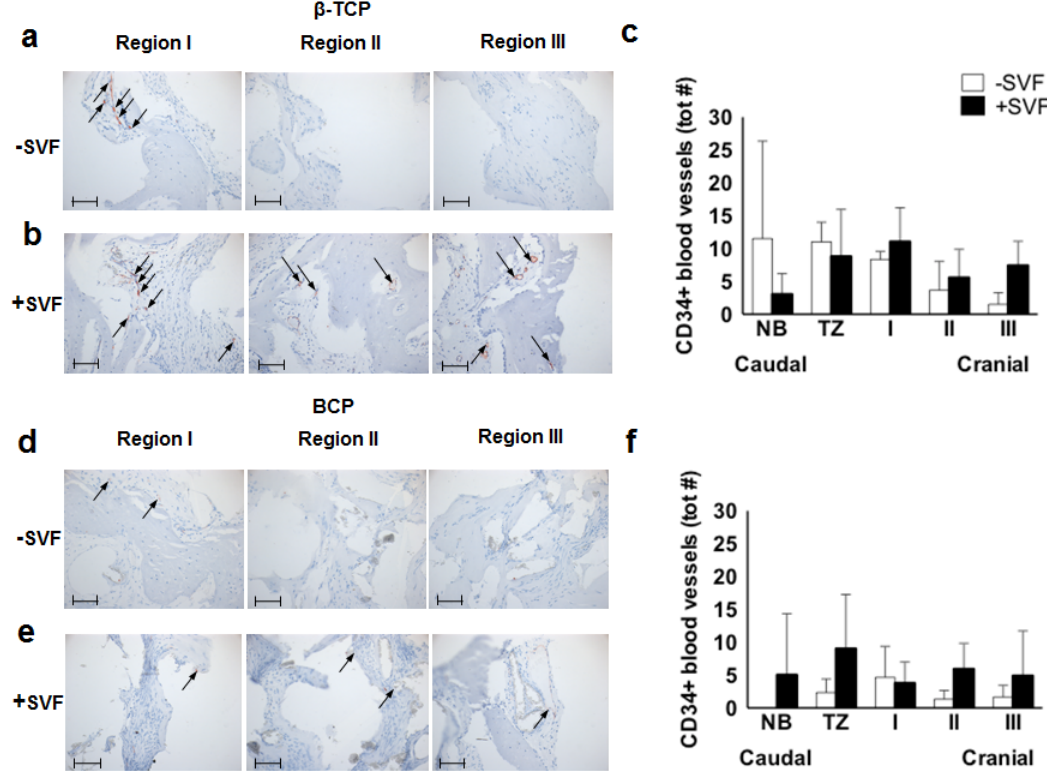
Figure 3. Immunohistochemical analysis of CD34, a marker of endothelial cells as well as stem cells such as endothelial progenitor stem cells and hematopoietic stem cells, of a maxillary bone biopsy from a patient treated with β -TCP ( a – c ) and BCP ( d – f ). Magnification: 200 × . The scale bar represents 100 µ m. The total number of CD34+ blood vessels of selected bone biopsies taken from control sides without stem cells (white bars; n = 3), and study sides with stem cells (black bars; n = 4) from patients treated with β -TCP ( b ) or BCP ( e ). β -TCP, β -tricalcium phosphate; BCP, biphasic calcium phosphate; NB, native bone; TZ, transition zone; SVF, stromal vascular fraction; tot #, total number.